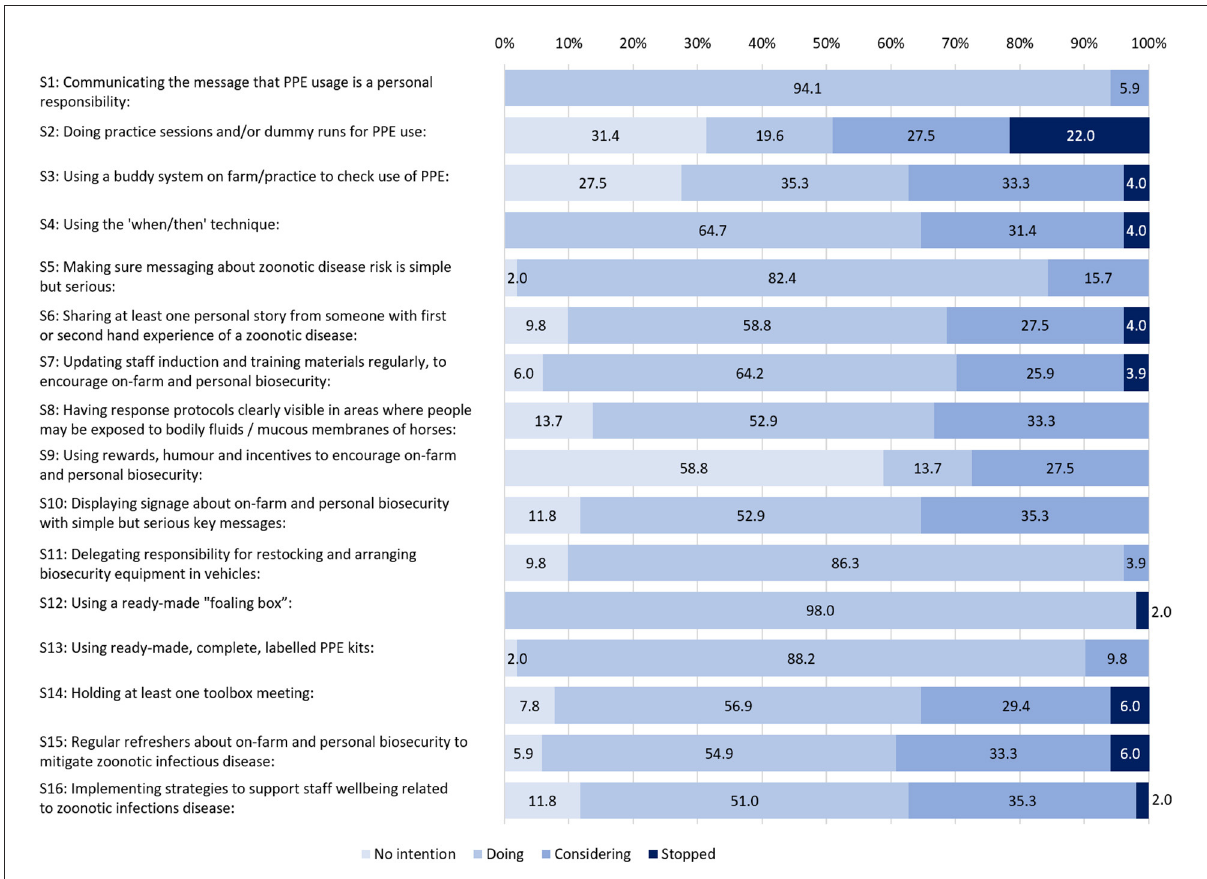
FIGURE2 The percentage of participants at different stages of strategy adoption with all three waves aggregated.